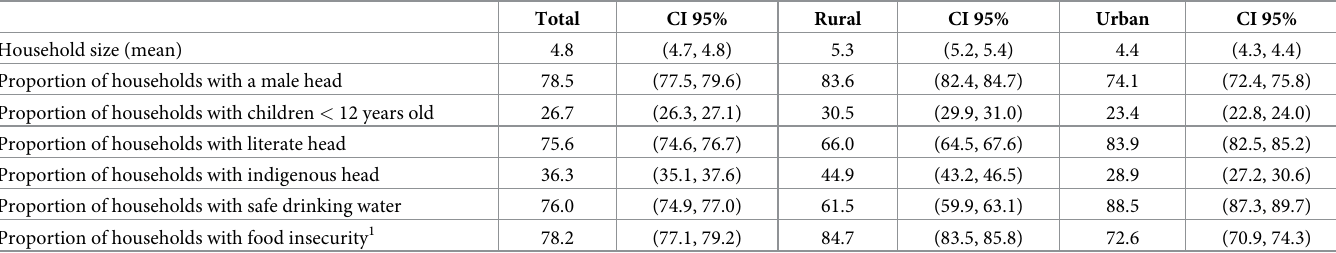
Table 1. Descriptive demographic variables by area, %.